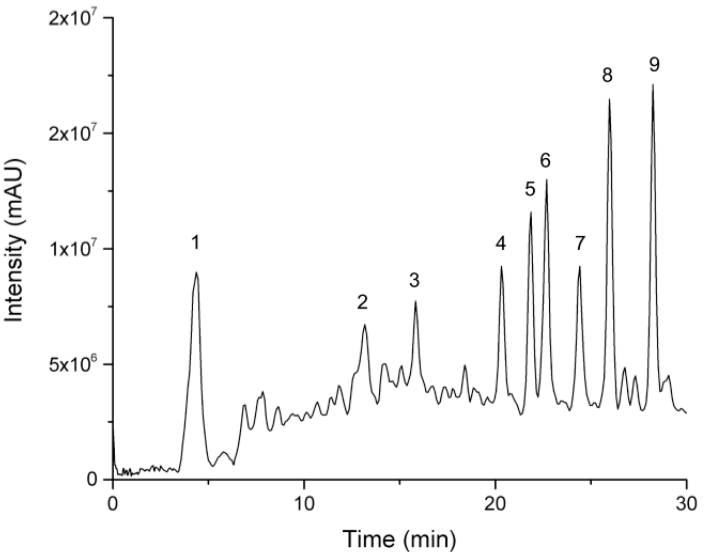
Figure 4. Fingerprinting by ion total chromatogram (TIC) of flavonoid-rich M. oleifera leaf extract (MOL-Flav) in the mineral cultivation condition (MIN) first harvest by HPLC-ESI-QTRAP-MS/MS analysis in the negative ion mode. The majority of compounds are identified as numbers (1–9) and explained in the Table 4. Table 4. HPLC-ESI-QTRAP-MS/MS data of the compounds identified in M. oleifera hydroethanolic leaf extract (MOL-Flav) in the first harvest of the mineral cultivation condition (MIN).